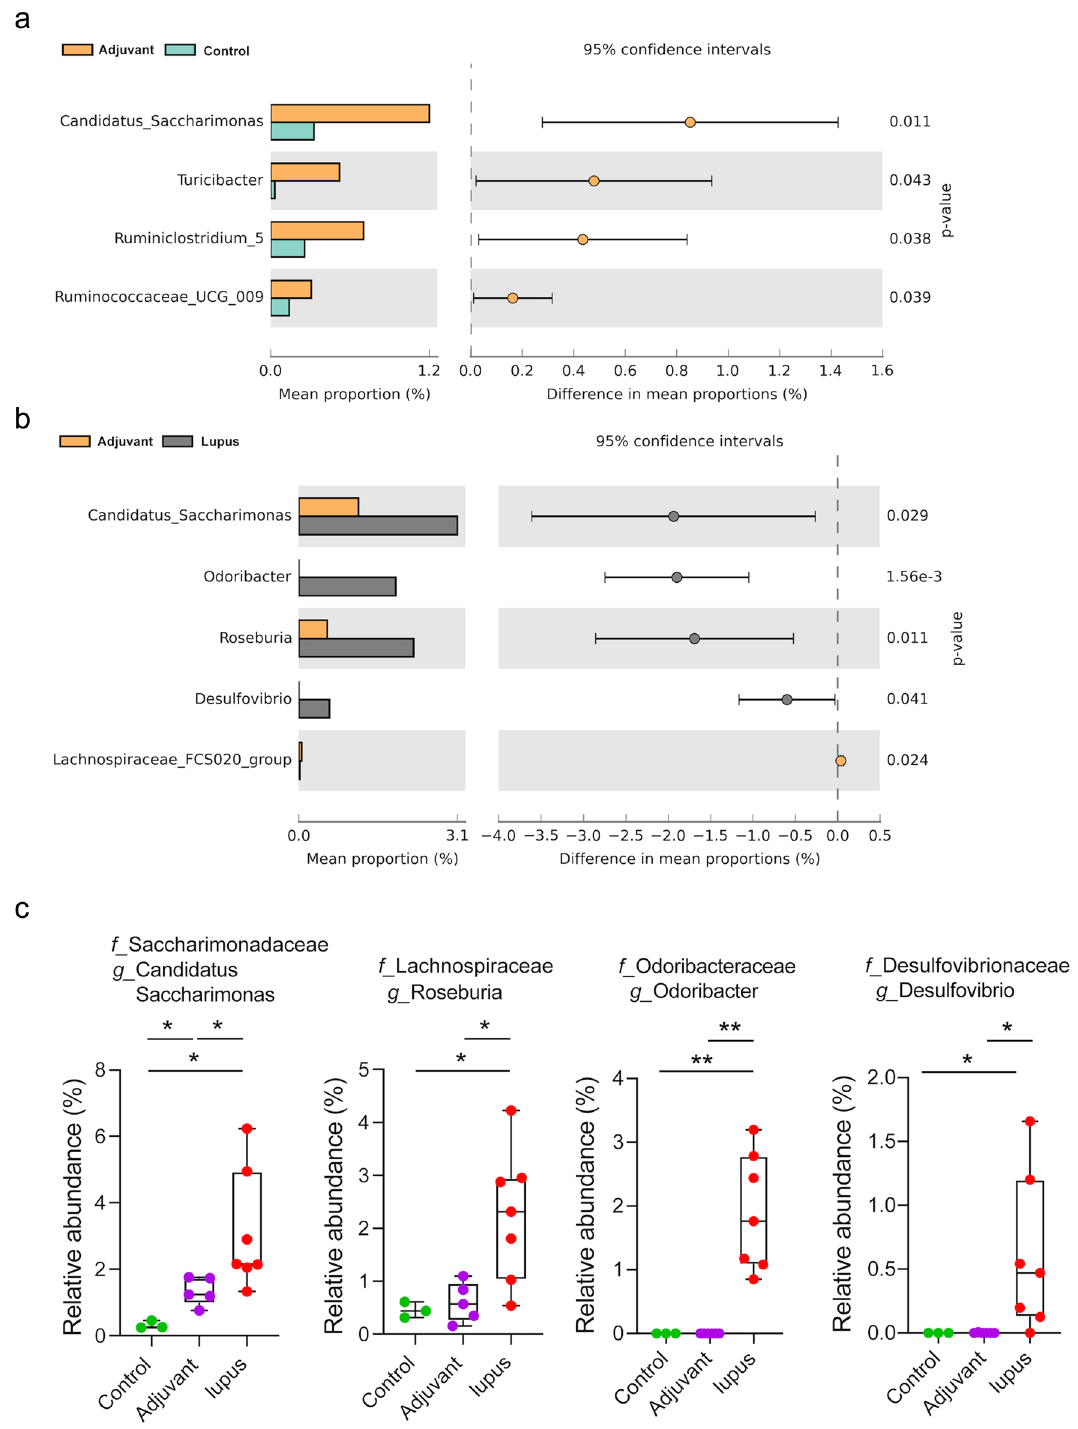
Figure 4. Relative abundance of genera in the fecal microbiota. The abundance of genera in the ( a ) adjuvant vs . control and ( b ) adjuvant vs . lupus groups analyzed by Welch’s t -test using STAMP software. ( c ) Genera